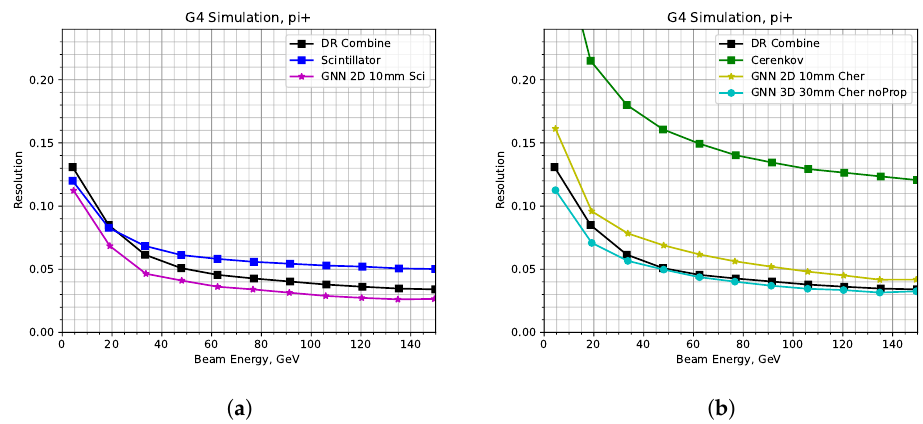
Figure 6. Energy resolution of various reconstruction methods for 4–150 GeV π + beams: ( a ) simple sum of signal and GNN reconstruction using only the scintillation and ( b ) only the Cherenkov signal. The resolution by the DR technique is shown in both plots as a